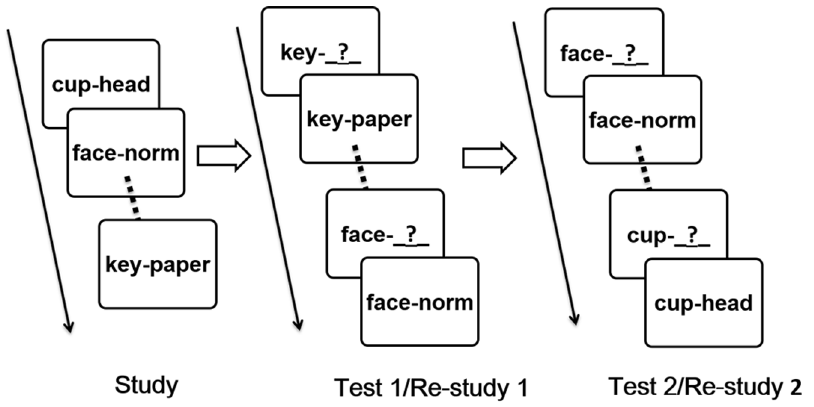
Figure 1. Illustration of Study and Test Procedure. All experimental materials (i.e., word pairs) were presented in Chinese.